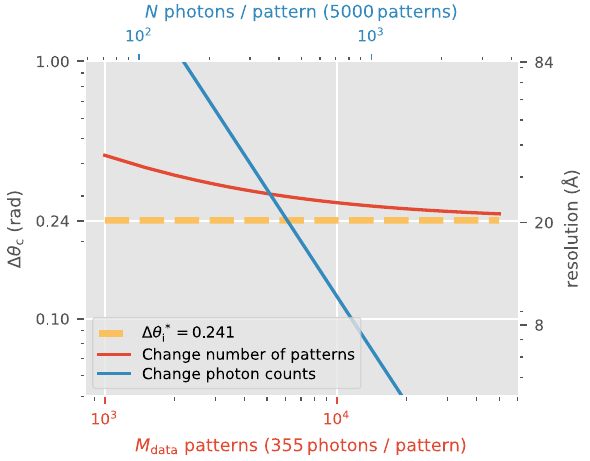
Figure 8. This figure shows how �θ c changes by increasing number of patterns (red curve, with N ≈ 355 ) or number of photons per pattern (blue curve, with M data = 5000 ). The measure of orientation inconsistency given the ground truth, �θ ∗ i (yellow), is computed for N ≈ 355 . The right axis shows the relation to spatial resolution according to Eq. (7) ( 2 σ